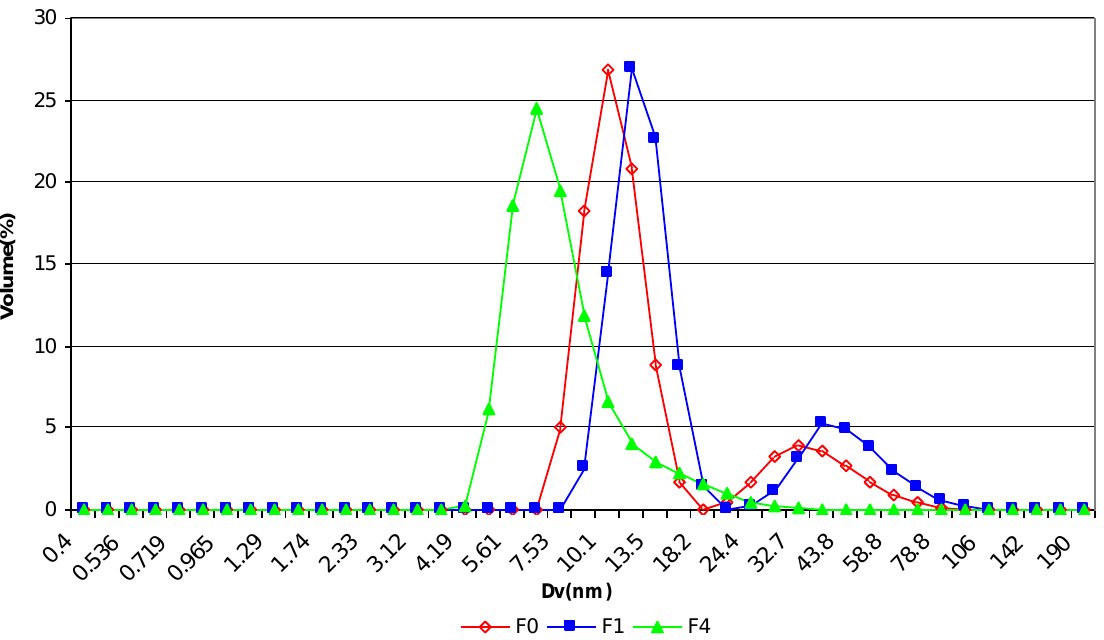
Figure 3. DLS-size distributions: Dv for fractions F (1 wt% solution at 20 °C); F